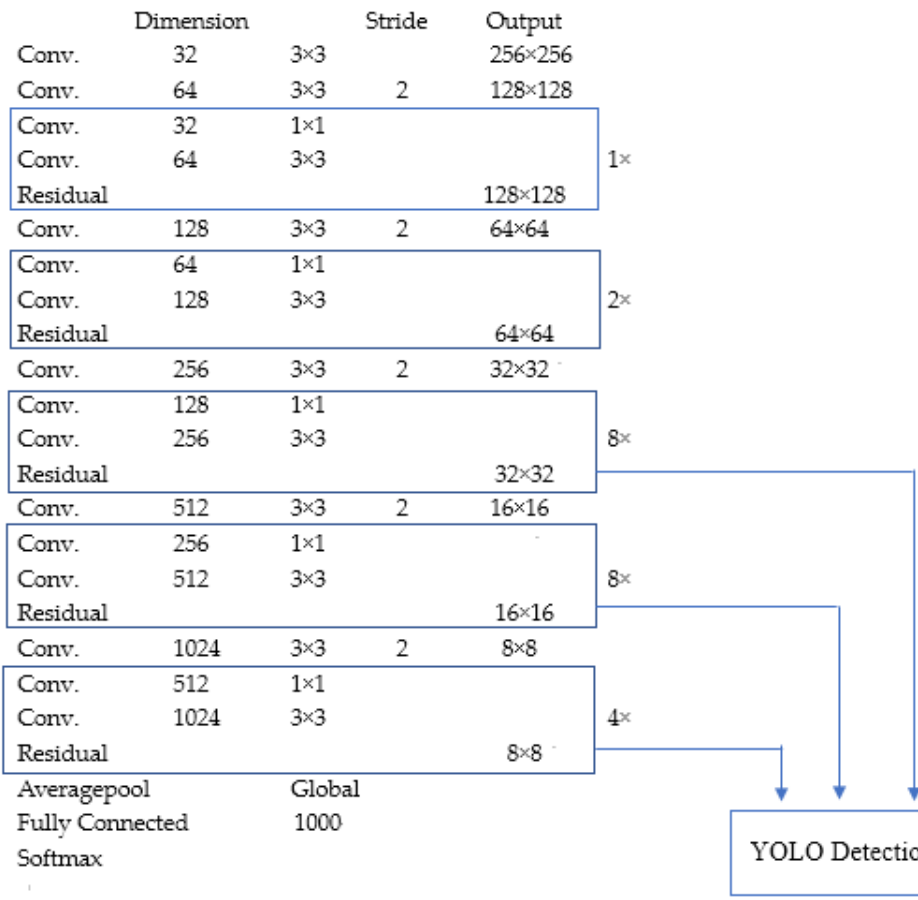
Figure 4. The network structure of YOLOv3. YOLOv3 uses the idea of Feature Pyramid Networks. Small-size feature maps are used to detect large-size objects, and large-size feature maps are used to detect small-size objects. YOLOv3 concatenates the output feature maps of 32 × 32, 16 × 16, 8 × 8 for detection.